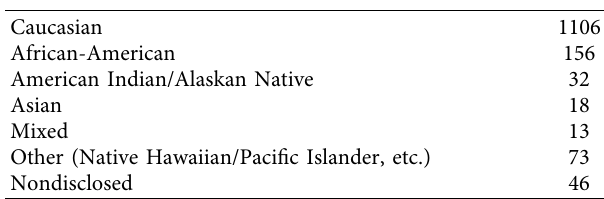
Table 2: Races of the patients.